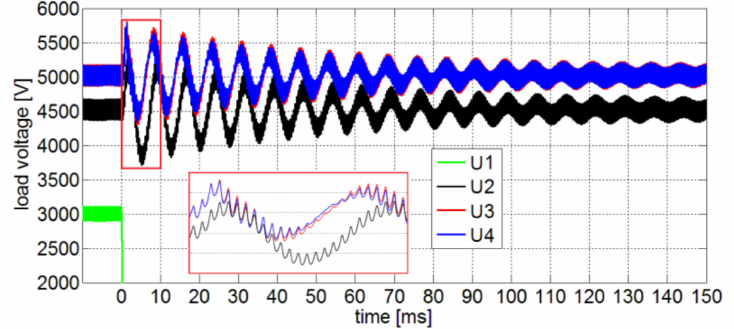
Figure 11. Load voltages transient in Case 3 (each Y-division is 500 V in zoomed graph).